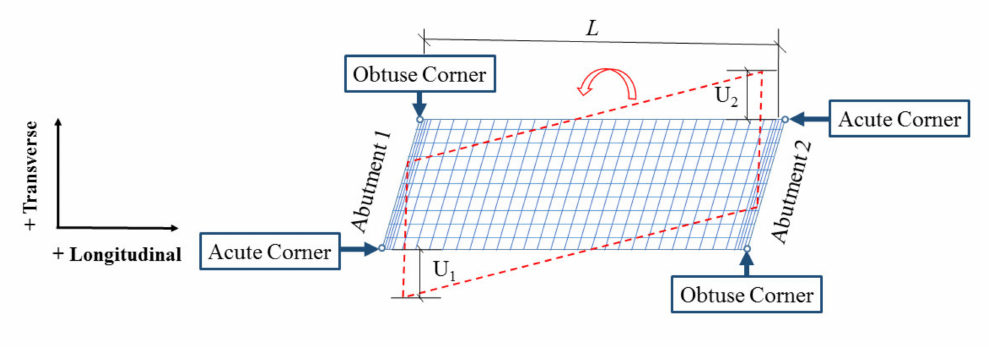
Figure 7. Abutment displacement and bridge deck in-plane